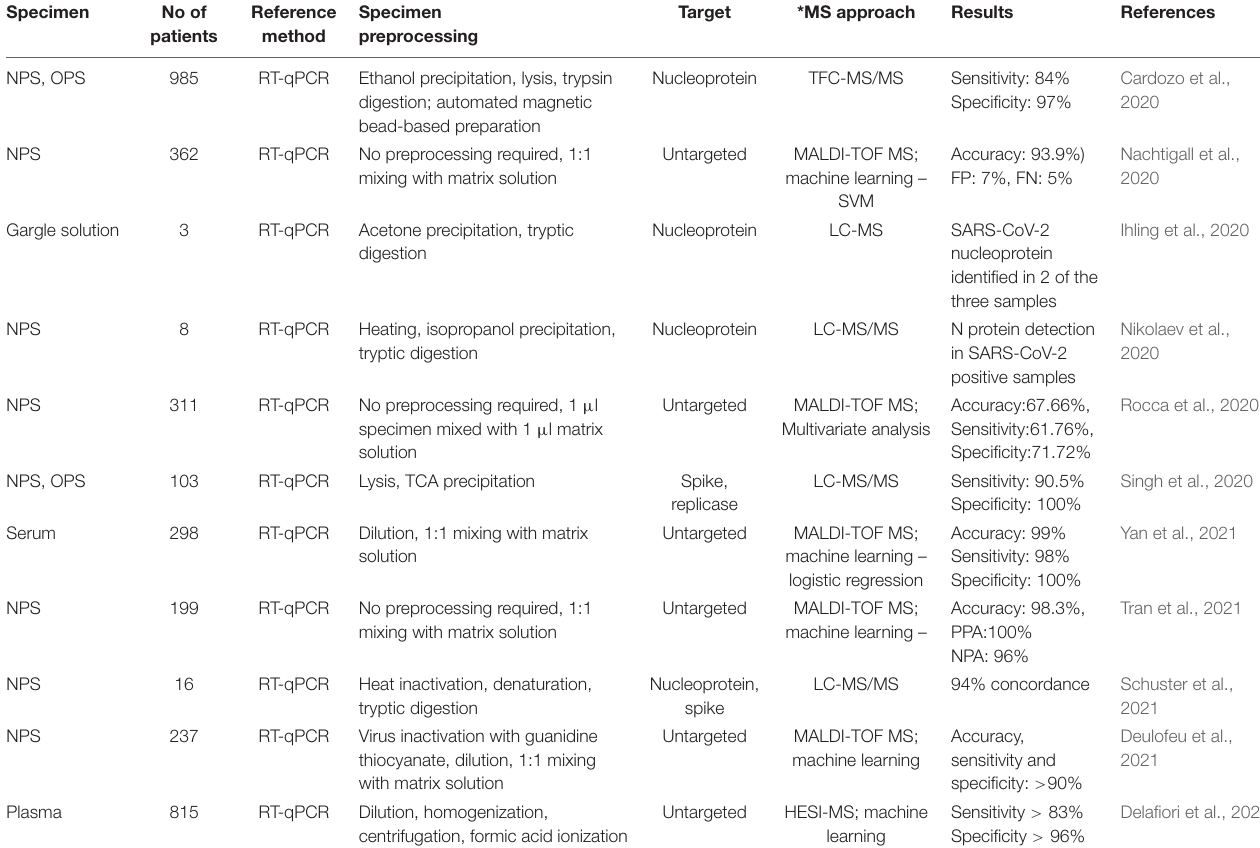
TABLE 2 | COVID-19 testing by